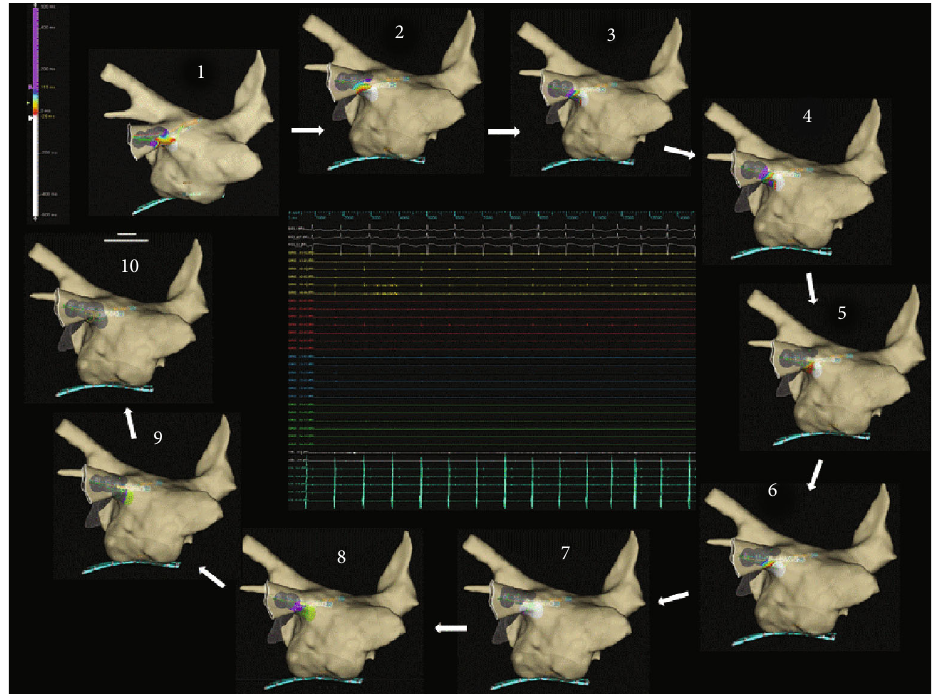
Figure 2: “ Live view ” tool allows to instantly view the presence of conductive gaps in vein isolation and their disappearance. Beat to beat activation map visualization (1 to 10), EGMs recordings show PV signal disappearance during ablation (HD grid in vein ostium during